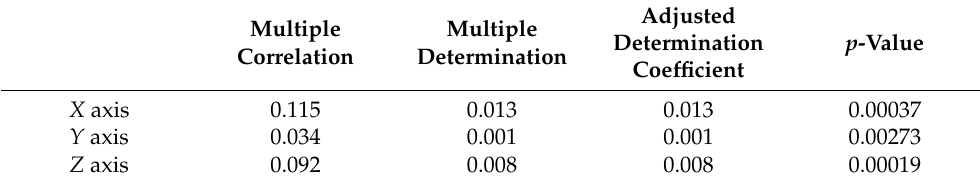
Table 2. Statistical indicators of the proposed model